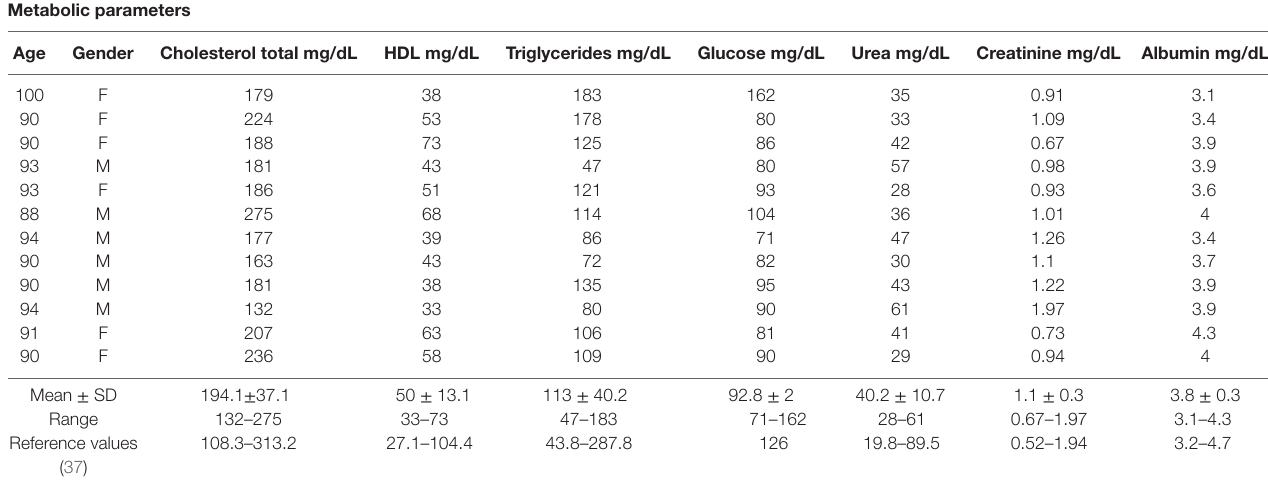
Table 1 | Metabolic parameters in old individuals (80–100 years) and reference values of 80-year-old individuals (37). Metabolic parameters age gender cholesterol total mg/dl hDl mg/dl